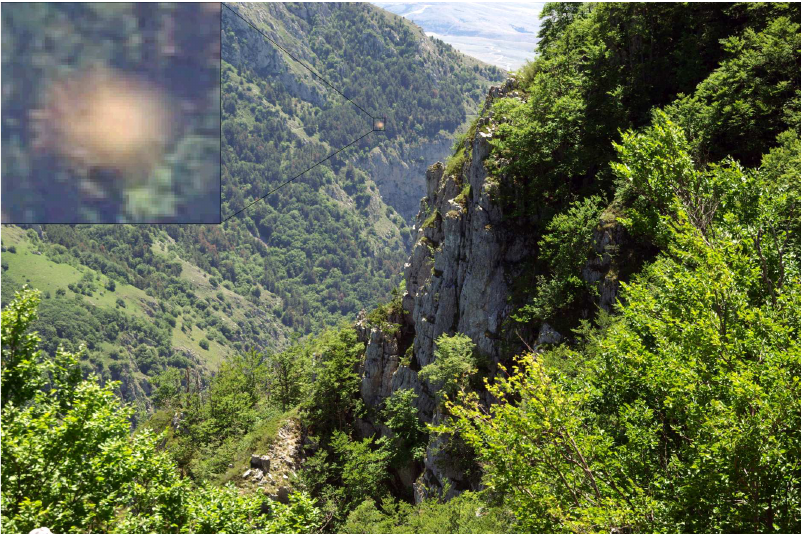
Fig. 3. A luminous body from the Celano Gorges, about 30km south of Aquila, at about 11:14LT on June 20, 2008. Courtesy of Bruno Chiarelli. time of the November 1461 earthquake (Galli, 1910). Fire beams were sighted from the historical center of Aquila, Scoppito, Sassa and Coppito. They appeared on and around the time of the stronger events. In all, 4 beams were observed, and each had a horizontal orientation. The light was either white, yellow, orange or red, and in some obser- vations were like a beam of an automobile headlight. Ms. Marcella Del Vecchio from Pile spotted a horizontal beam of bright orange light, which was moving from North-West to South-East coming from Coppito toward her house dur- ing the main shock. The sky was clear and she could see the stars, the beam did not illuminate objects despite being very bright. The beam was shaped like a sickle. She had the impression that it was wrapping her house. Luminous funnels , as conical structures of light, usually yellow, orange or red, with very well defined borders were observed. They were oriented horizontally or obliquely. They were sighted in Coppito, Sassa and Poggio Picenze be- fore and after the main shock. Mr. Cosimo D’Ambrosio observed these funnels in Coppito after 4:00LT on April 6 at about the time of the first strong aftershock at 04:37, M=5.1,